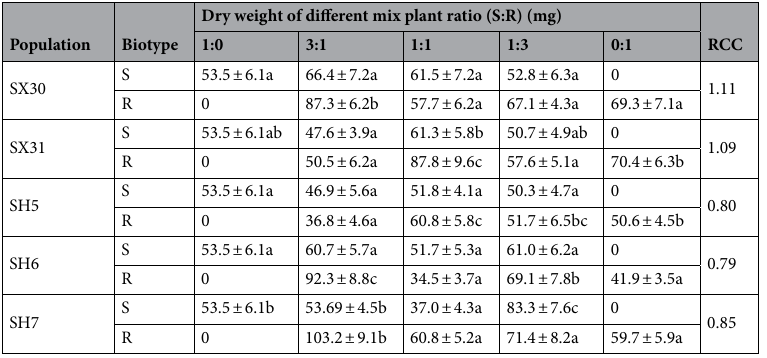
Table 5. The dry weight and RCC of D. sophia subpopulations from Henan and Xinjiang under admixture condition. Different lowercase indicated significant difference with p <0.05.